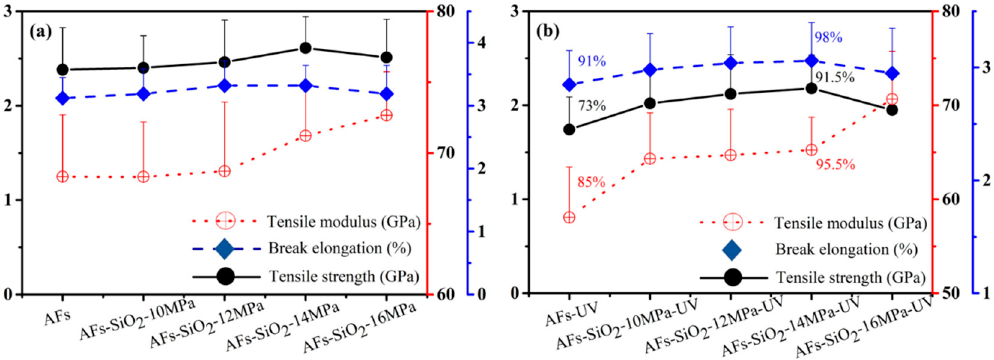
Figure 9. Mechanical properties of AFs and nano-SiO 2 -modified AFs before ( a ) and after ( b ) 216 h of UV radiation.